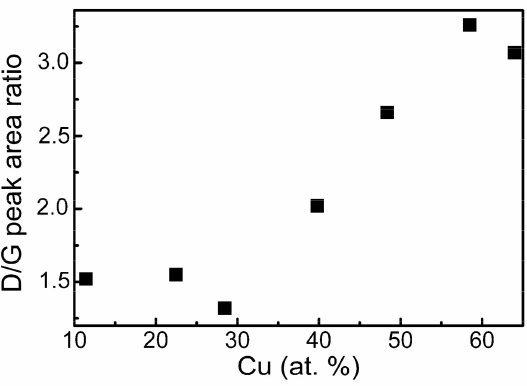
Figure 7. D / G peak area ratio Vs copper atomic concentration in DLC:Cu films.